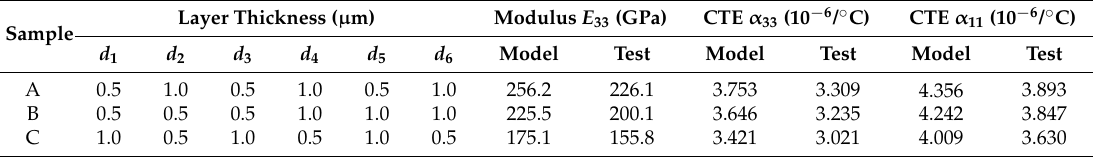
Table 3. Comparison of measured and predicted modulus and coefficients of thermal expansion